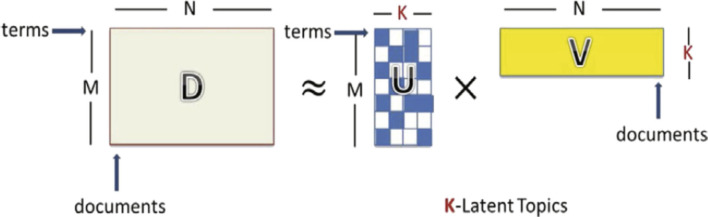
The original structure of the NMF topic model (Chen et al., 2019).